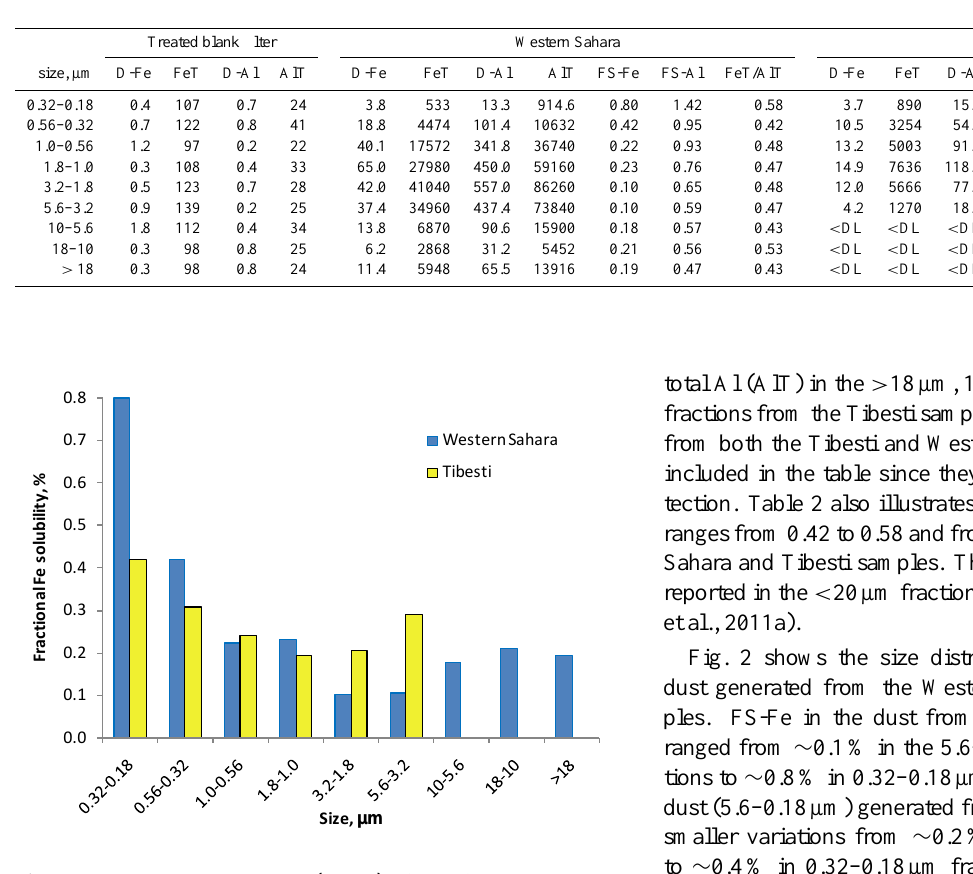
Table 2. As measured dissolved Fe (D-Fe), dissolved Al (D-Al), total Fe (FeT), and total Al (AlT) concentrations (unit: µgl − 1 ) , and frac- tional Fe solubility (FS-Fe) and fractional Al solubility (FS-Al) in the “treated blank filters”, Western Sahara and Tibesti samples measured using ICP-MS.